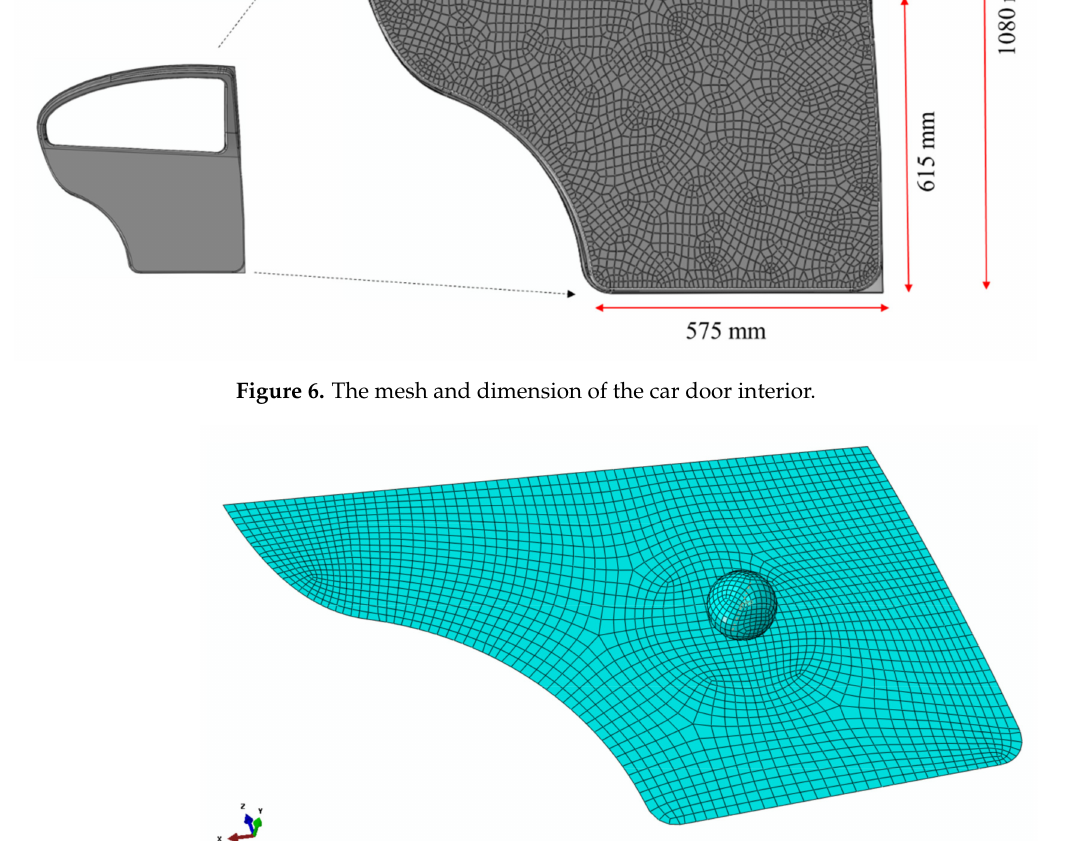
Figure 7. FE model perspective of the panel and the sphere.